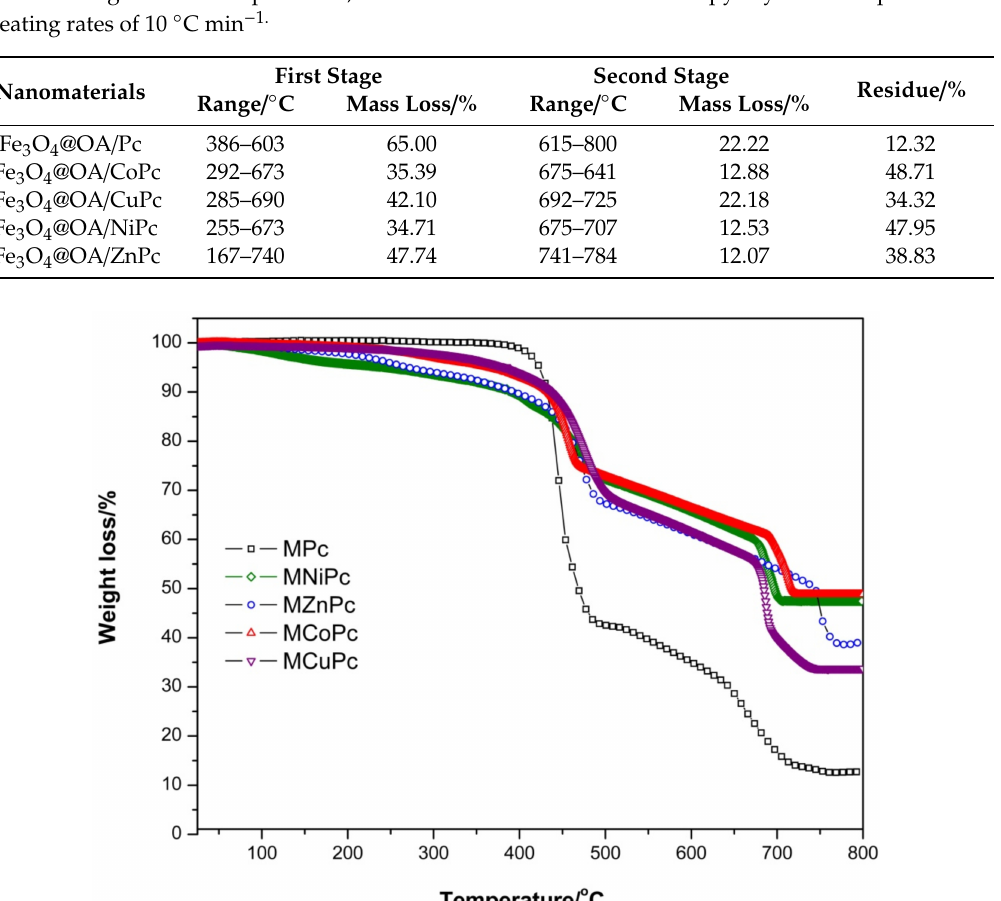
Figure 3. Thermogravimetric analysis of the Fe 3 O 4 @OA / Pcs under inert